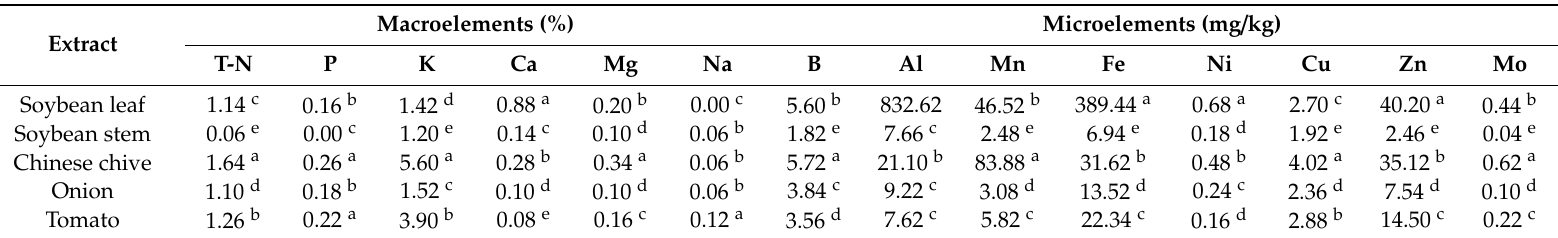
Table 2. Nutrition levels in various plant extracts.